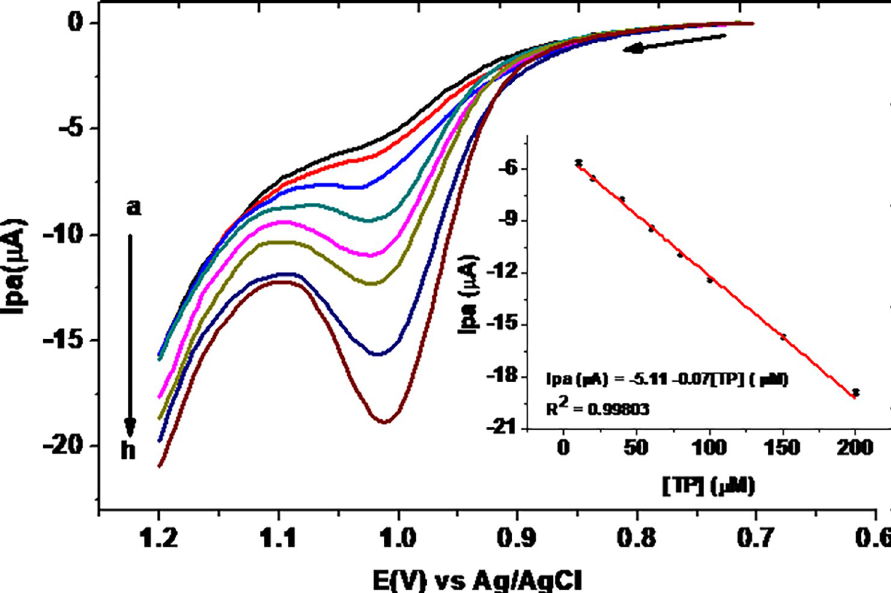
Fig 11. SWVs of 10% MCPE in pH 7.0 PBS containing various concentrations of TP (a-h: 10.0, 20.0, 40.0, 60.0, 80.0, 100.0, 150, and 200 μ M, respectively) at scan rate of 100 mV s -1 and default SWV parameters (step potential 4 mV, amplitude 25 mV & frequency 15 Hz). Inset: plot of average Ip vs concentration of TP (n